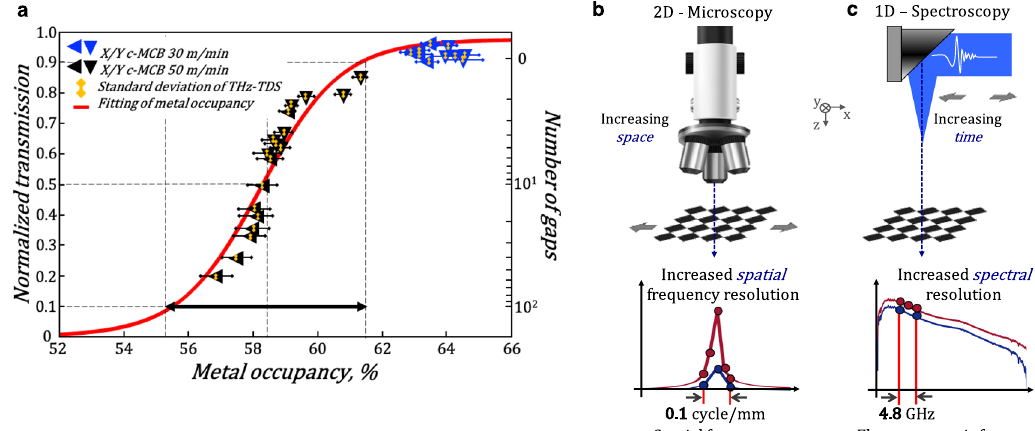
Fig. 3 2D optical microscopy vs 1D terahertz spectroscopy. a Comparison between OM and THz-TDS results, where normalized transmission from THz-TDS is plotted as a function of the metal occupancy. The red line shows the fi t with the logistic function. The black arrow shows the sensitive zone of metal occupancy. Illustration of the concept of spectral resolution for b optical microscopy and c